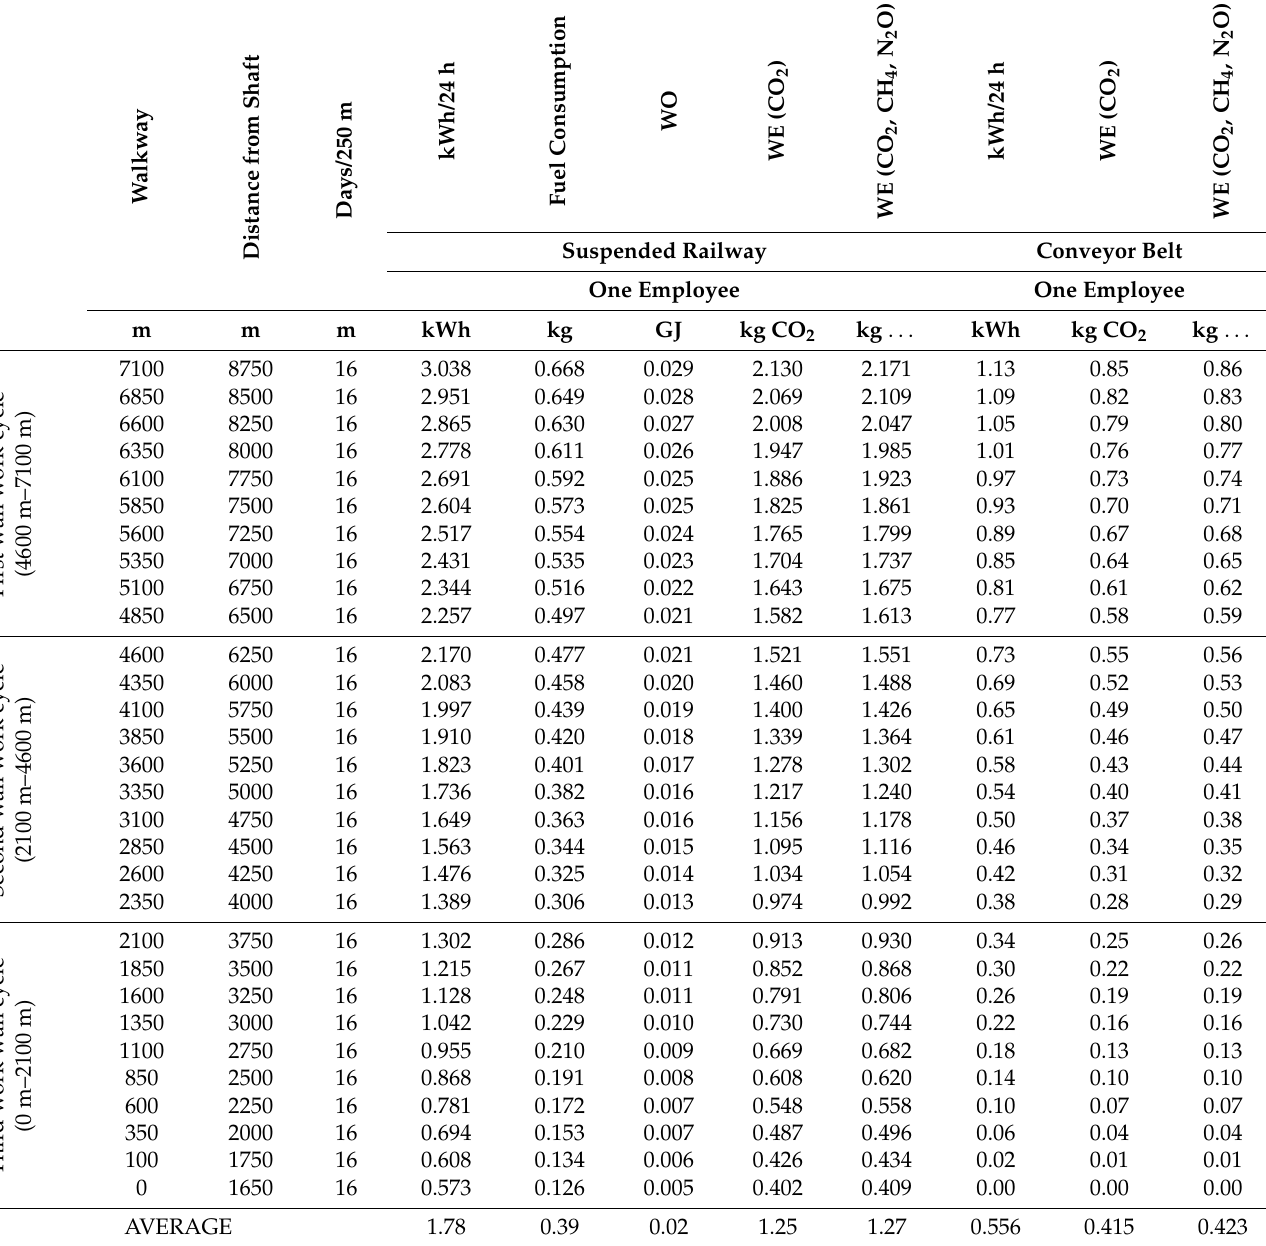
Table 8. Results of GHG energy intensity and emissivity calculations for one